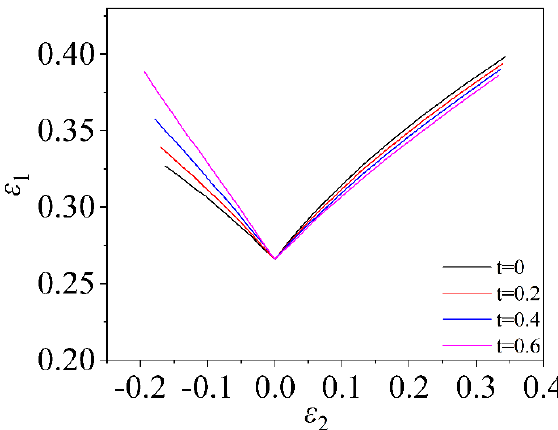
Figure 9. FLD of material TRIP780 based on Hill48 yield criterion and MMFC instability criterion.